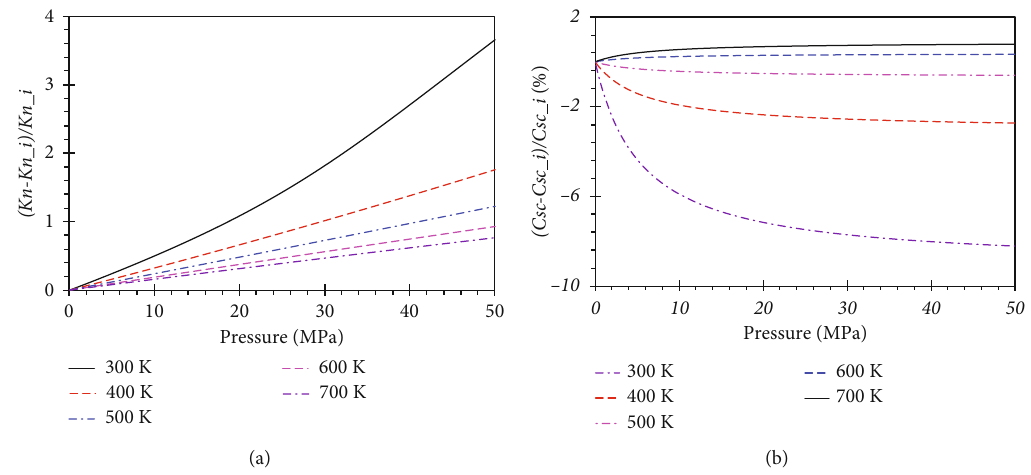
Figure 6: Variation of key parameters caused by real gas e ff ect: (a) Kn ; (b) Gas concentration.